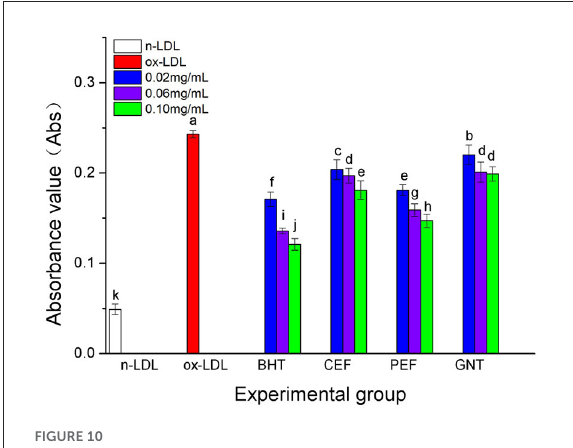
FIGURE10 The TBARS generative effect of CEF, PEF, and GNT at different concentrations. Different lowercase letters indicate significant differences between each individual experimental group ( p <